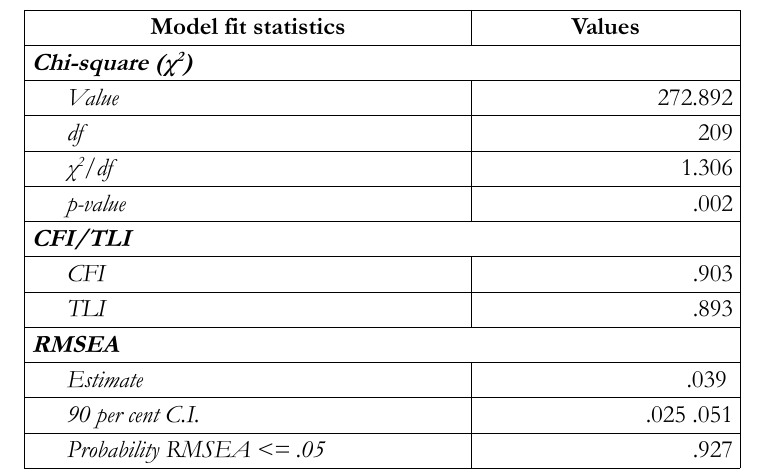
Table 2. Selected goodness of fit indices of the one-factor PKMT